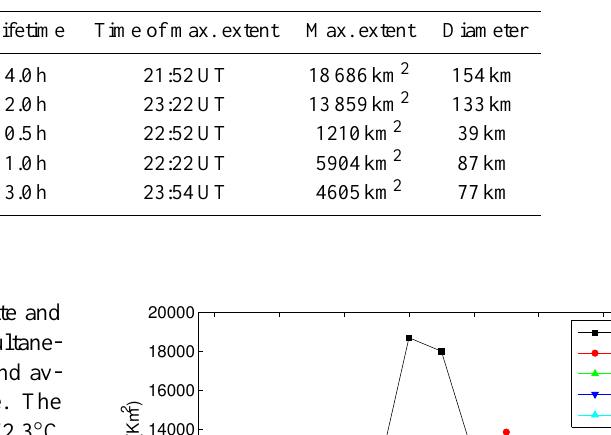
Table 3. Convective Regions’ temporal and spatial parameters, 25–26 October 2005.